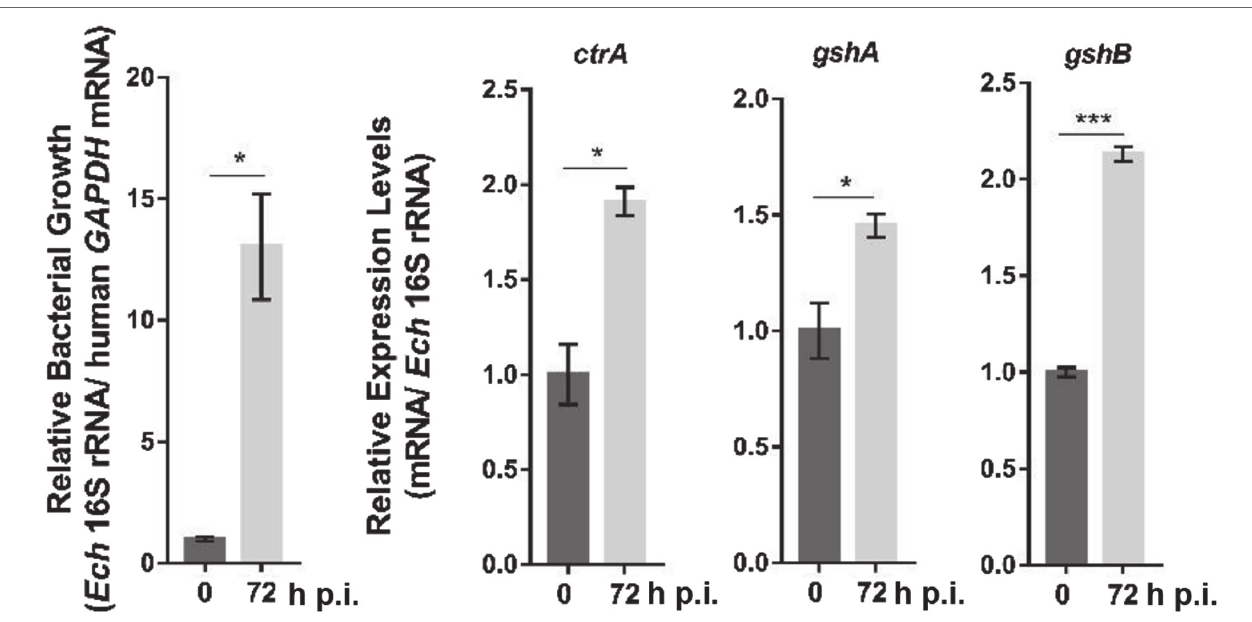
FIGURE 3 | The expression of ctrA , gshA , and gshB at different stages of E. chaffeensis intracellular growth. RNA samples were prepared from synchronously cultured E. chaffeensis in THP-1 cells at 0 h and 72 h p.i. The expression levels of each gene were determined with qRT-PCR and normalized against those of E. chaffeensis 16S rRNA. Relative values to the amount at 0 h p.i. are shown. Data indicate means ± standard deviations ( n = 3). The significant differences are represented by p -values determined with Student’s t -test (* p < 0.05, *** p < 0.001).